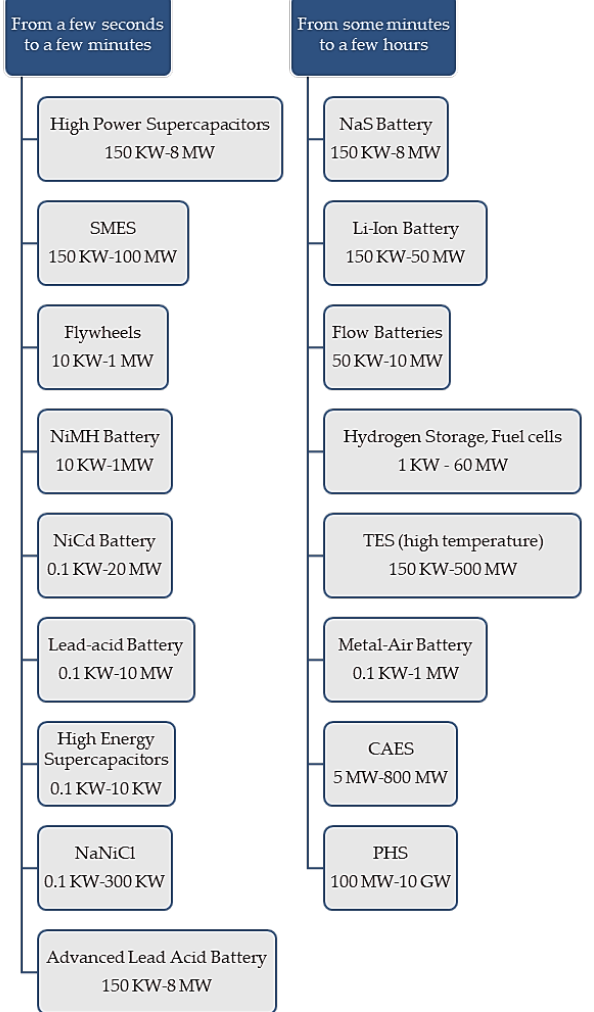
Figure 2. Utility-scale energy storage technologies by typical discharge time and power capacity ranges based on [39].